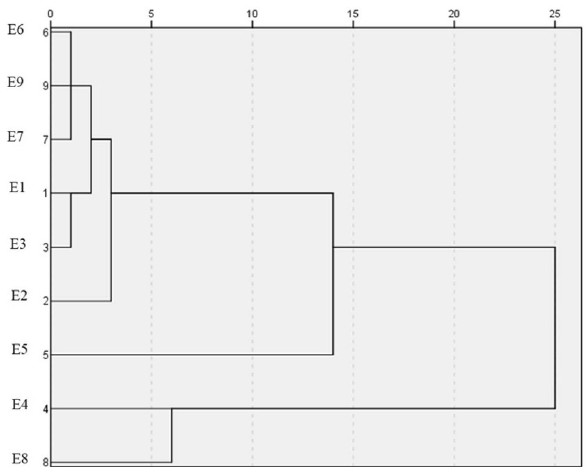
Figure 2. Dandrogram of essential oil compounds cluster analysis. E1: A.tournefortiana (Kerman province), E2: A.tournefortiana (North Khorasan province), E3: A.tournefortiana (West Azerbaijan province), E4: A.khorassanica (South Khorasan province), E5: A.khorassanica (North Khorasan province), E6: A.khorassanica (Semnan province), E7: A.haussknechtii (Kohgiluyeh and Boyer-Ahmad province), E8: A.haussknechtii (Isfahan province), E9: A.haussknechtii (Chaharmahal and Bakhtiari